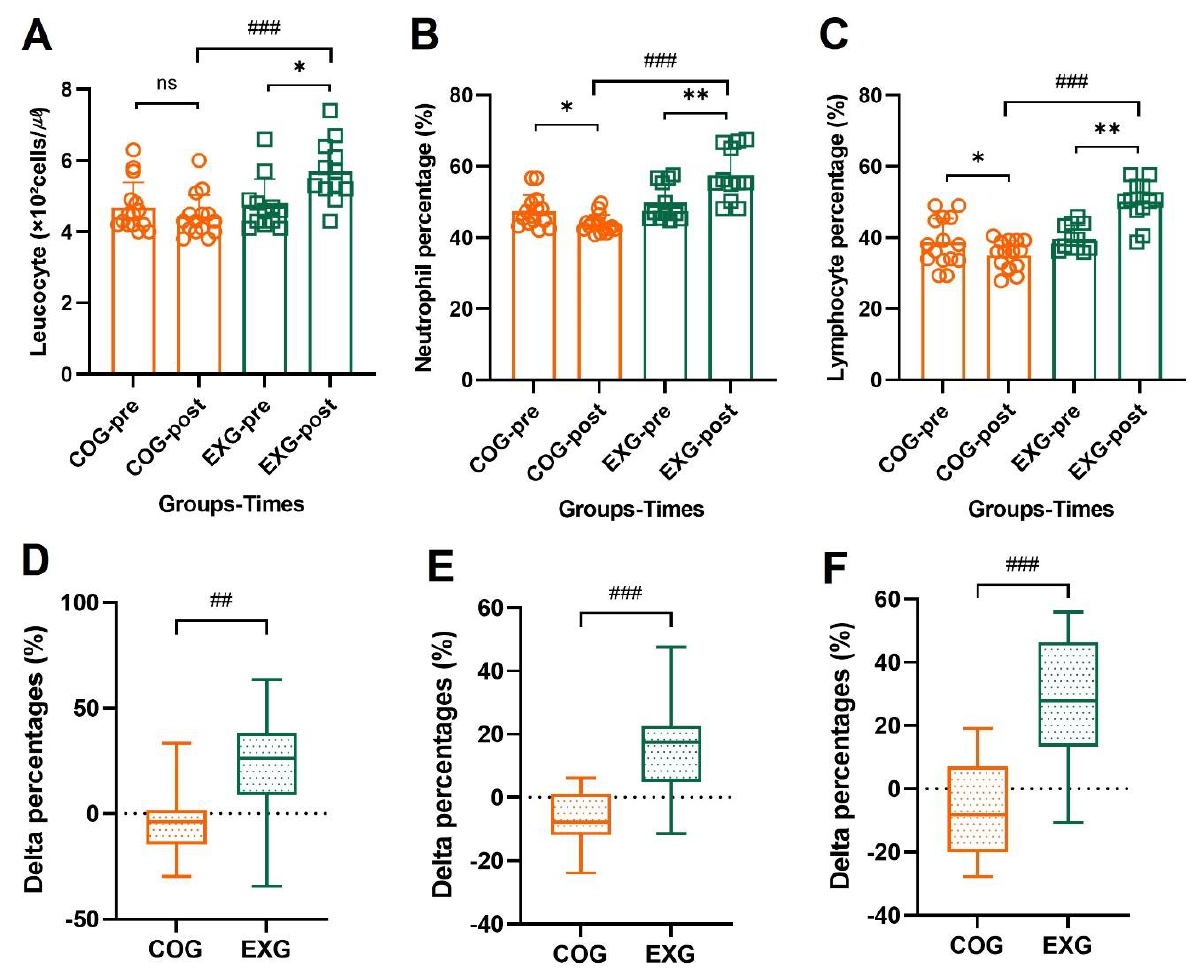
Figure 5. Neutrophils and lymphocytes of leucocytes are improved in the ovarian cancer survivors after 12 weeks of aerobic and resistance exercise. ( A ) Leucocyte’s absolute values in the control group (COG) and in the exercise group (EXG). ( B ) Neutrophil percentages of leucocyte’s absolute values in the COG and EXG. ( C ) Lymphocyte percentages of leucocyte’s absolute values in the COG and EXG. ( D ) Percentages of leucocyte analyzed as ∆ % in both groups. ( E ) Percentages of neutrophil analyzed as ∆ % in both groups. ( F ) Percentages of lymphocyte analyzed as ∆ % in both groups. All data are represented as means ± SD. p -values were calculated by Student’s t test or Mann–Whitney U test. For ( A ) to ( F ), these tests were performed independently at each time point; # p < 0.05, ## p <